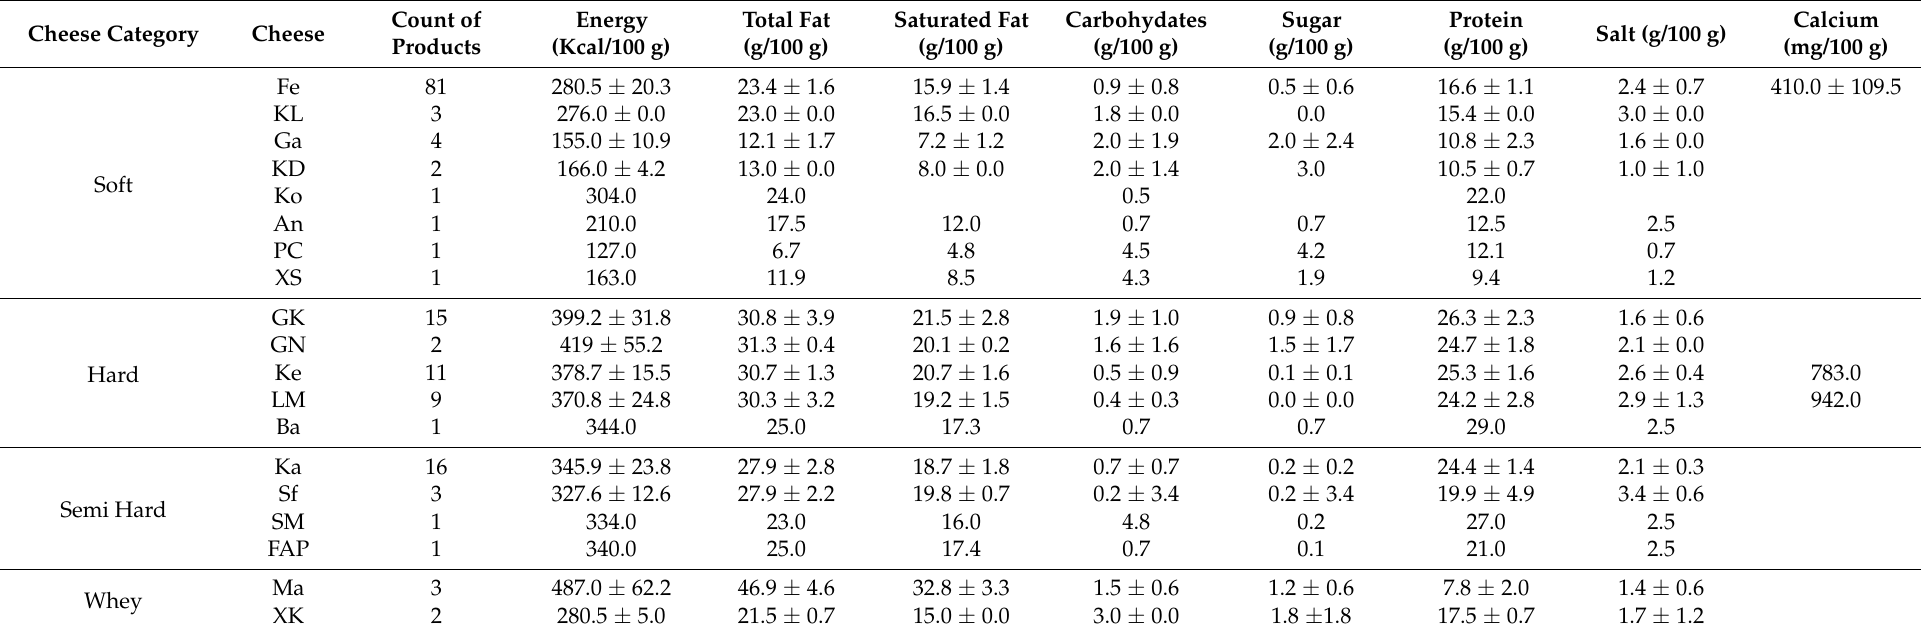
Table 3. Nutritional composition of Greek prepacked “quality label” cheeses, according to their labelling nutrition declaration tables. Cheese